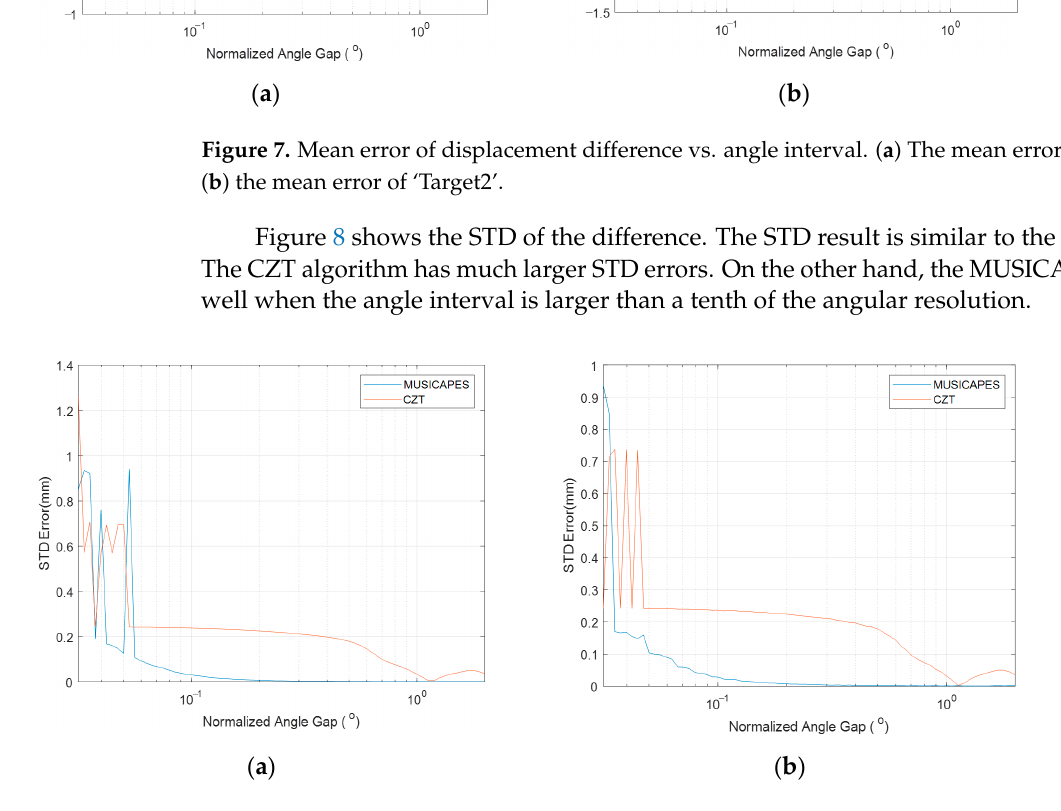
( b ) Figure 9. Mean error of displacement difference vs. array length. ( a ) The mean error of ‘Target1’; ( b ) the mean error of ‘Target2’.